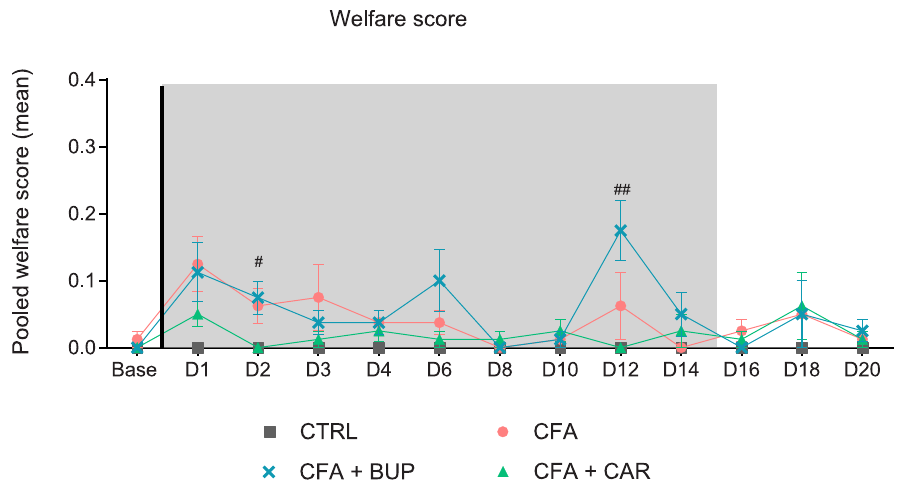
Fig 1. Welfare assessment (WA) scores. The figure shows pooled mean WA scores collected daily with the score sheet shown in Table 2. Statistics are calculated on ranks (Kruskal-Wallis test, followed by Dunn’s multiple comparisons test), but values are displayed as means ± SEM for ease of viewing. The hash sign ( # ) represents a statistically significant difference between CFA + BUP and CFA + CAR at # p < 0.05 and ## p < 0.01. For all graphs: base = baseline values, D = day, the line represents the day of analgesic treatment initiation (D0) and the grey area represents the treatment period (15 days). All groups, n = 8, male Sprague Dawley rats.